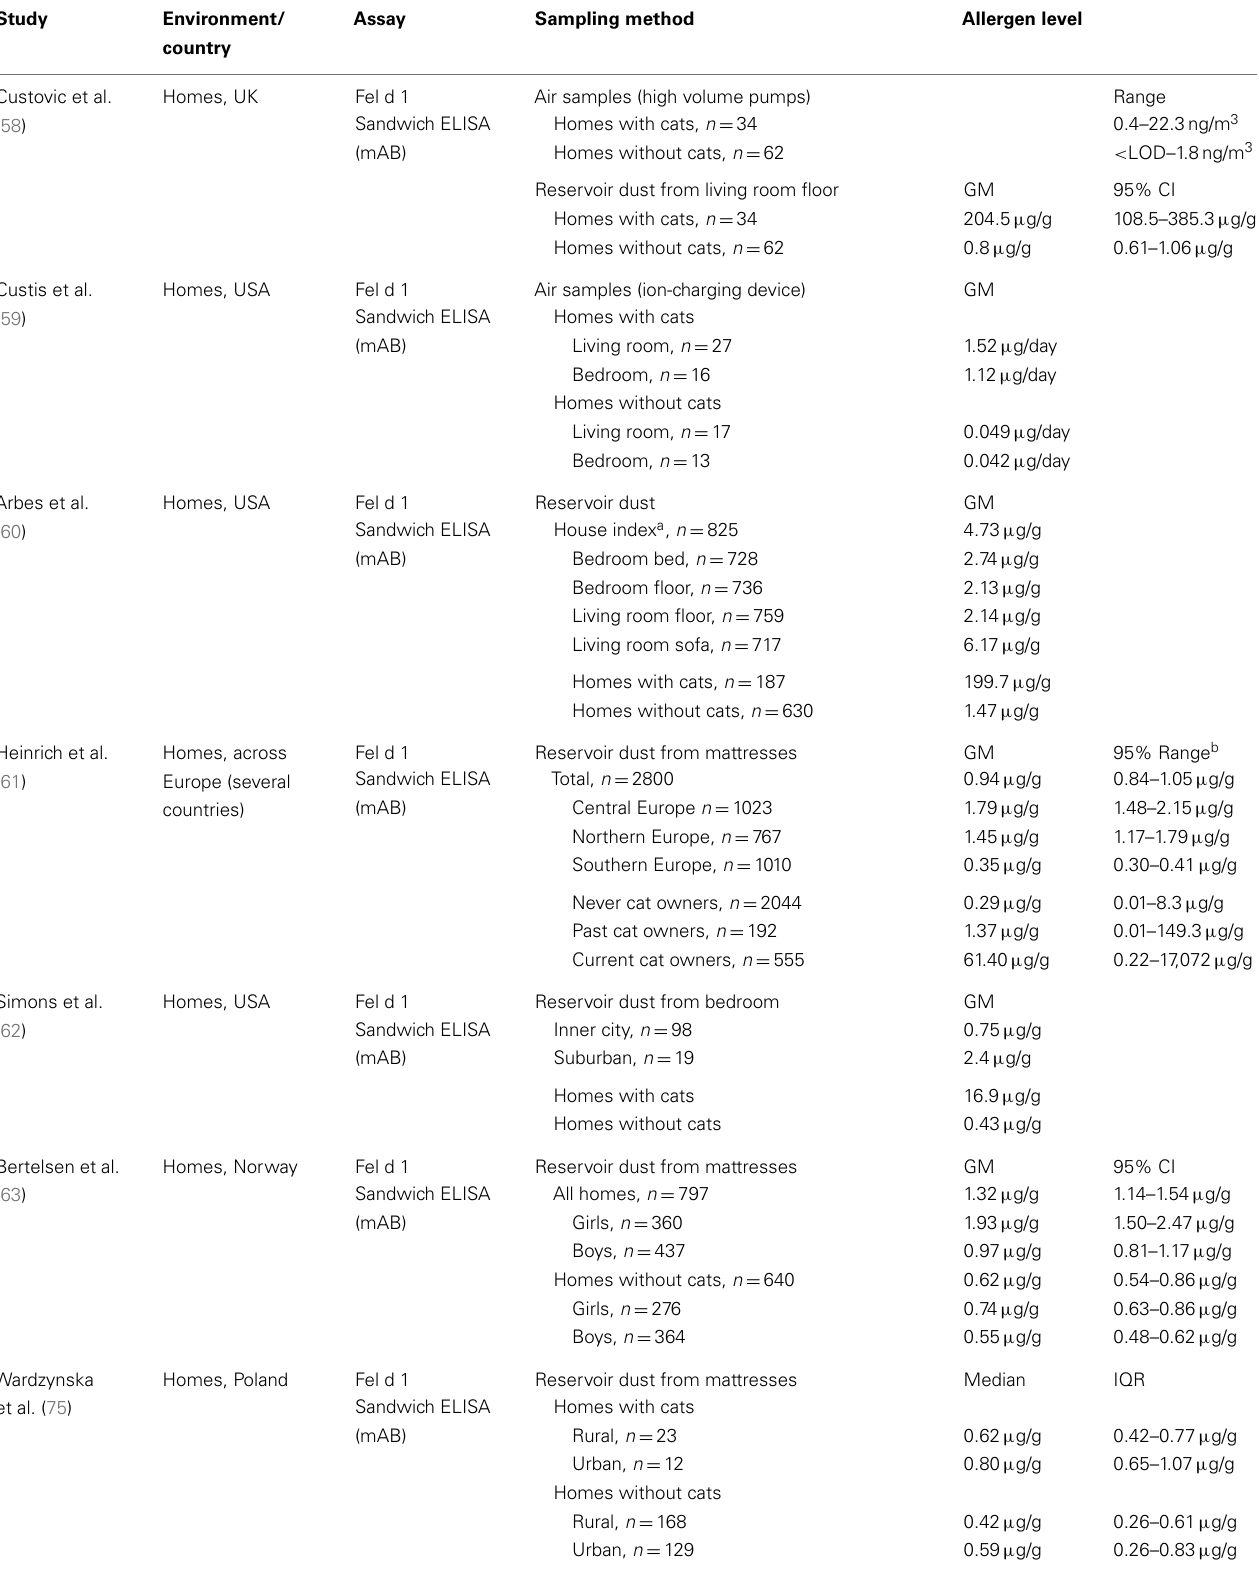
Table 1 | Studies related to exposure assessment to cat allergen